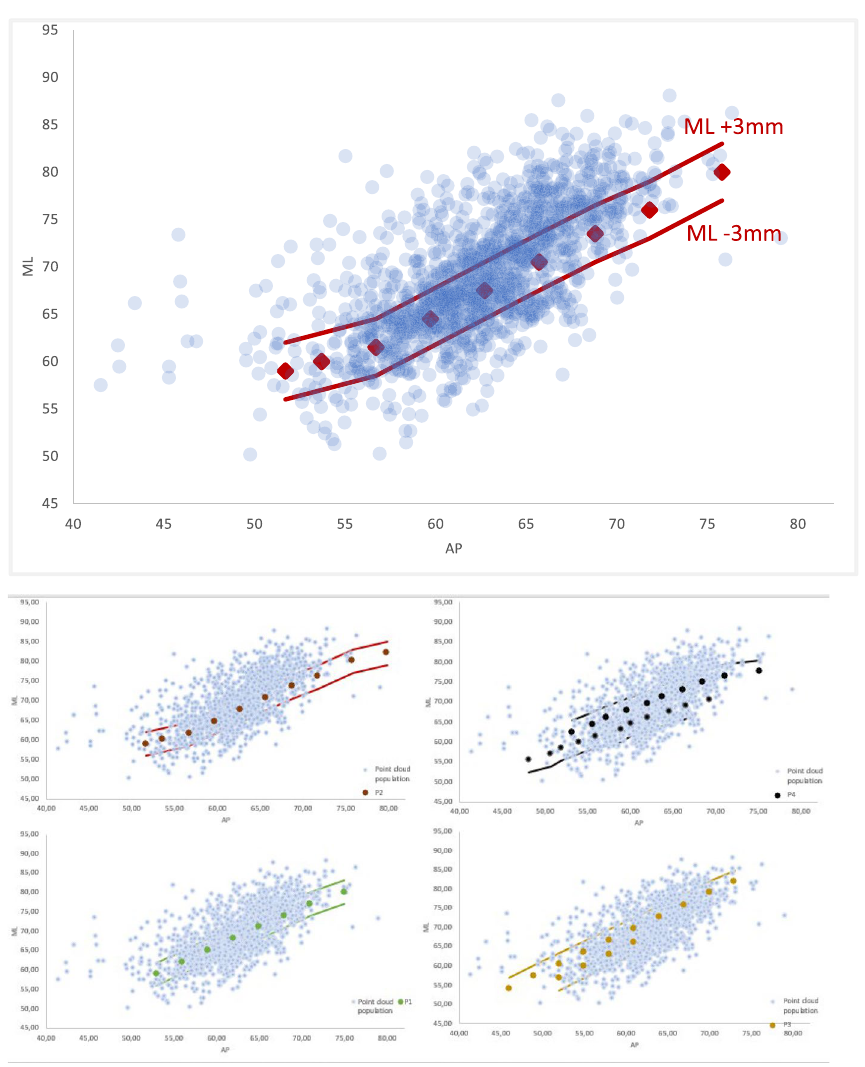
Fig. 4 For each OTS there is a line representing the average and parallel lines for ML